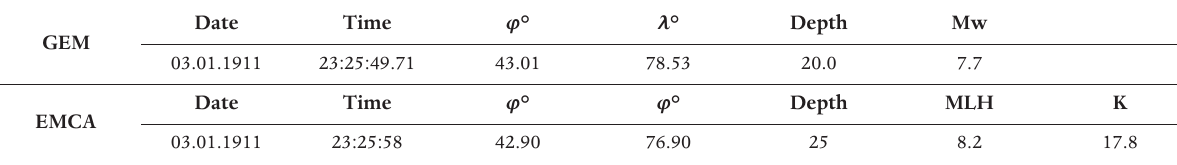
Table 2. The parameters of Kemin earthquake in ISC-GEM and EMCA